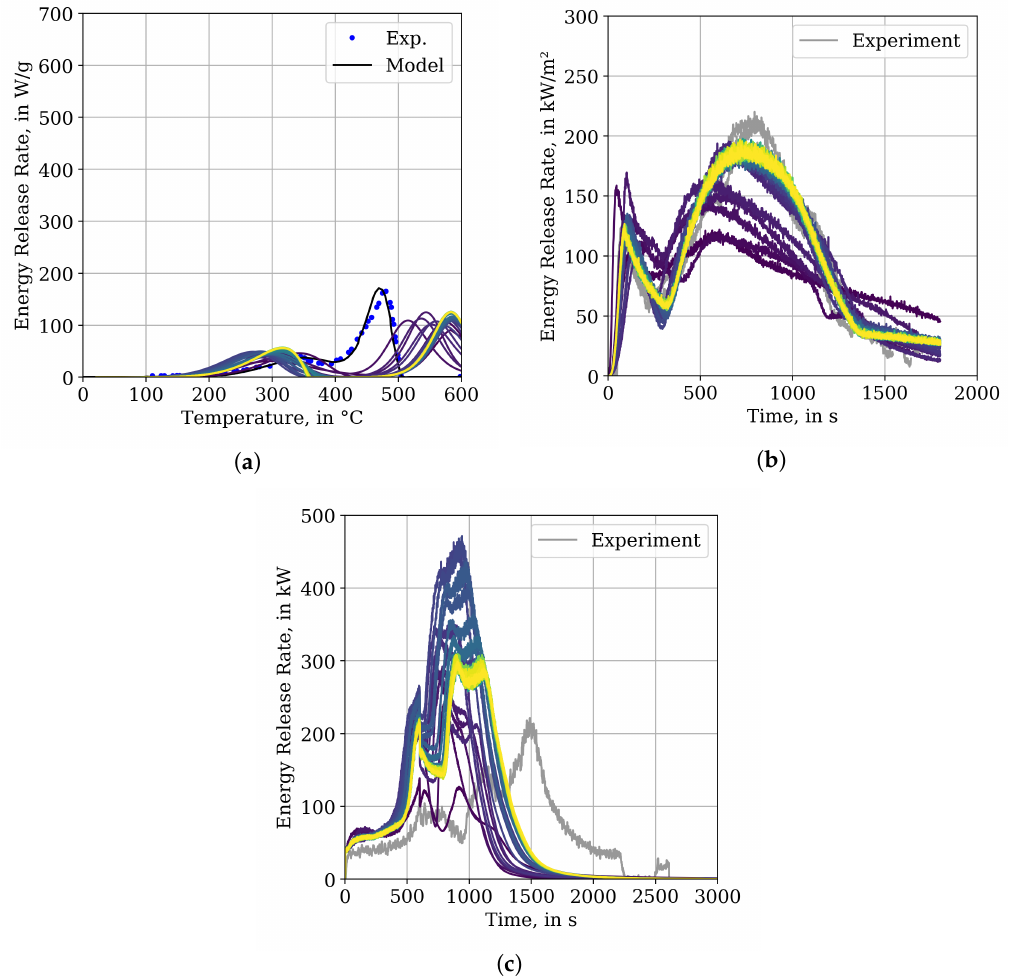
Figure A7. Development of the response from the best parameter set per generation, for IMP T b (50 kW / m 2 ), compared to experimental data [15]. Dark blue represents generation 0, yellow represents generation 47. ( a ) MCC simulation results of the jacket material. ( b ) Cone Calorimeter simulation results. ( c ) MT3 simulation results.